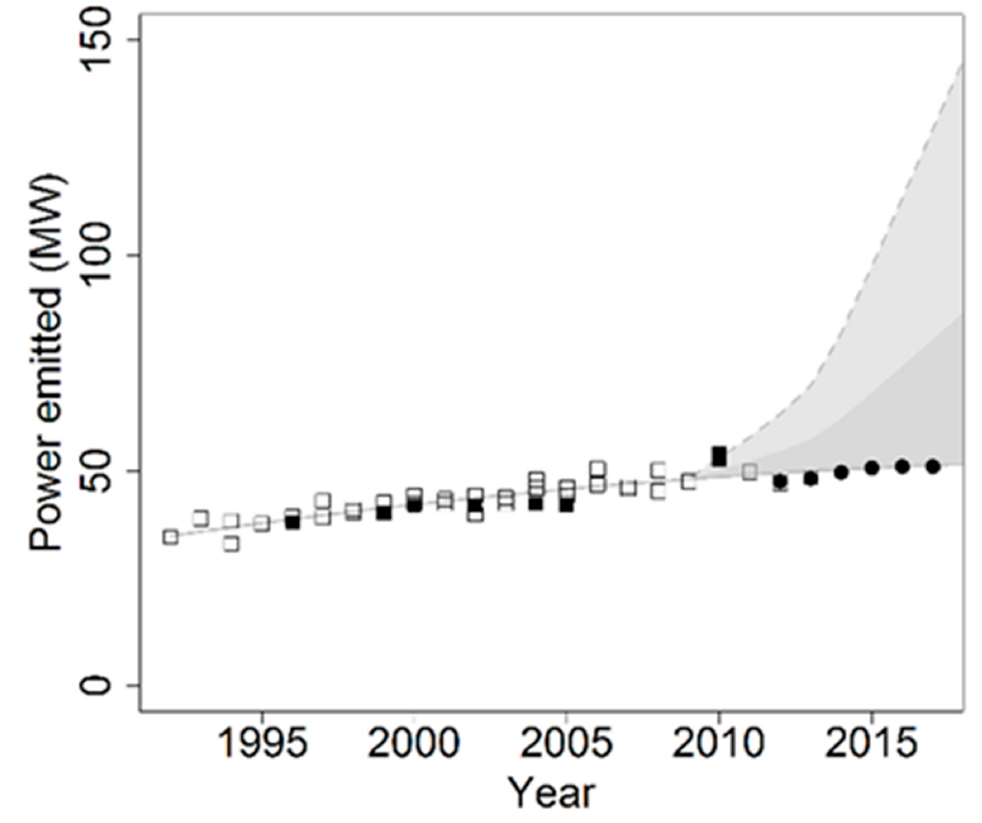
Figure 3. Global emitted power (Nikon blue band [14]) detected by satellites from artificial light sources from 1992 to 2017. Open squares represent annual DMSP-OLS composite data, filled squares represent radiance calibrated DMSP ‐ OLS data, filled circles represent VIIRS Day/Night band data. Plotted data points assume constant spectral composition of light emissions. The shaded areas represent the possible range of undetected light assuming a recent phased transition from high pressure sodium lighting to LEDs of color temperature 3000 K (dark grey) or 4000 K (light grey). At the country scale, marked patterns of a decrease and increase in detected emitted power of lighting are often related to countries in conflict or recovering from conflict dur ‐ ing this period (Figure 2); Syria [1], Ukraine [50], Central African Republic, and Yemen [51] (see Figure S9) all show marked decreases in emitted power of lighting over the pe ‐ riod, while Bosnia and Herzegovina, Afghanistan, Angola, Mozambique and Somalia all show decreases. Declines in Nigeria and Uzbekistan are apparently due, in large part, to